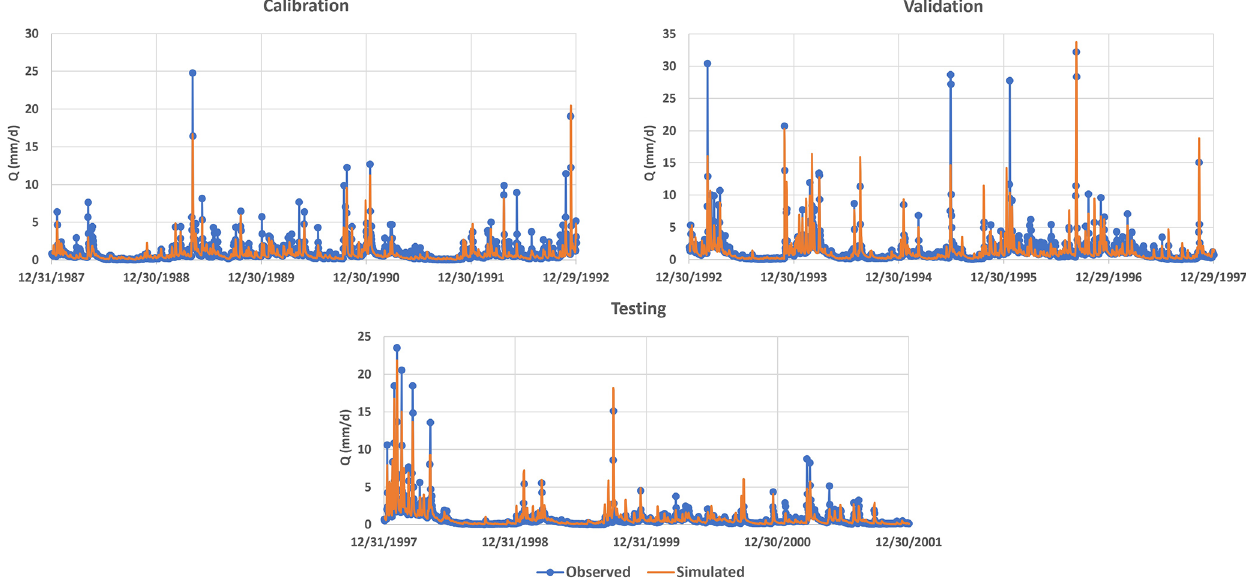
Figure 6. Simulated hydrograph of MIKA-SHA_SUPERFLEX with the observed hydrograph of the basin.